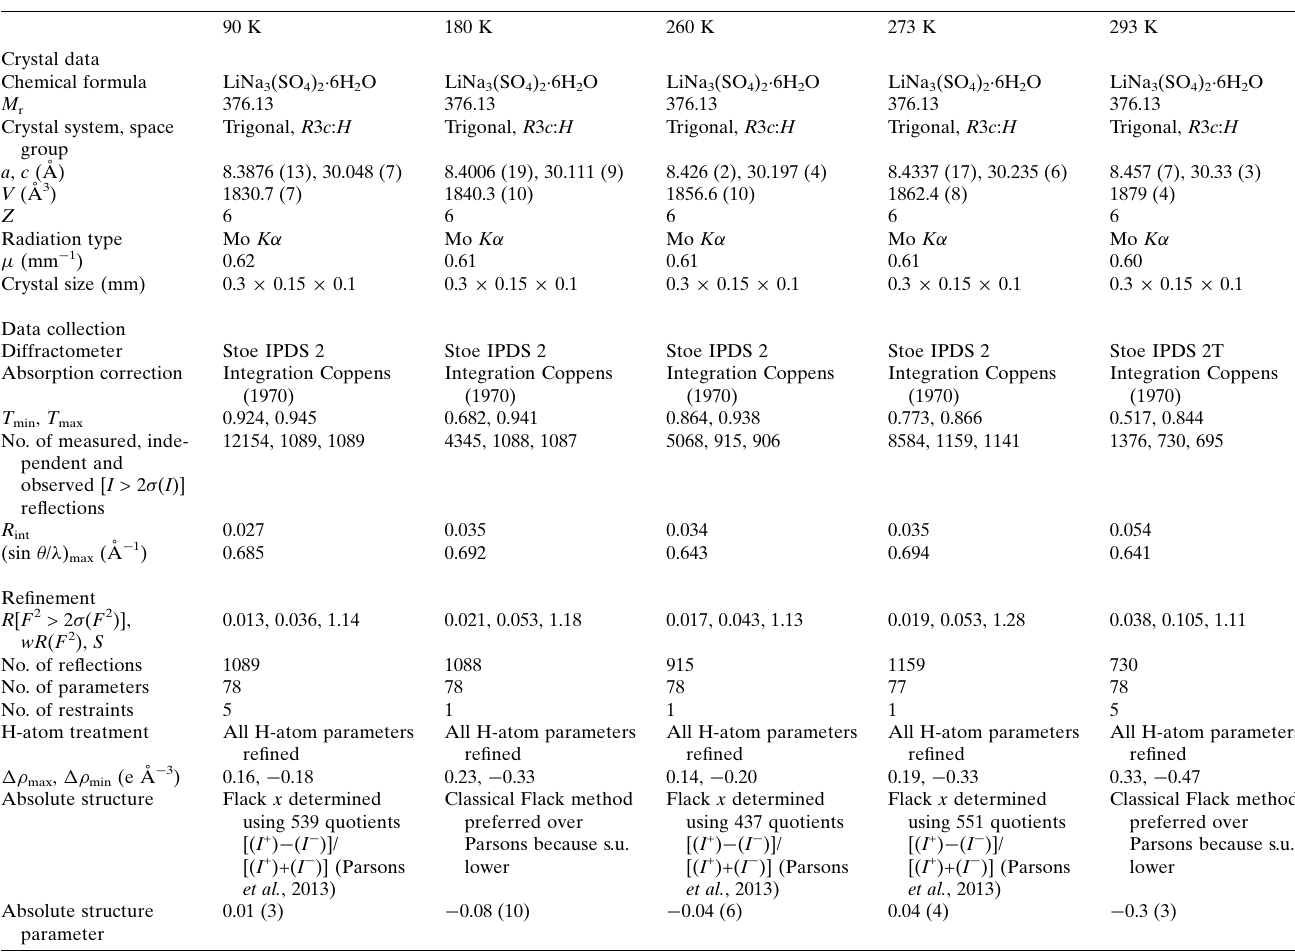
Table 2 Experimental